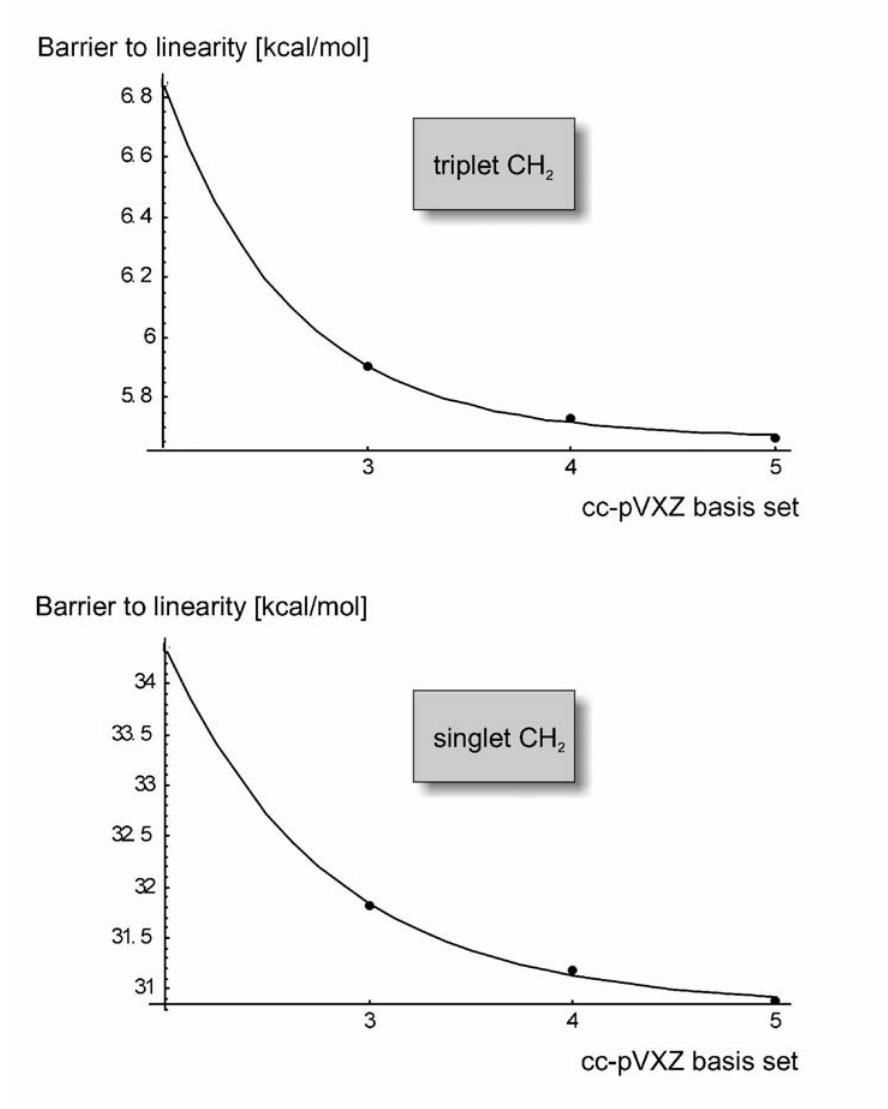
Figure 1. Exponential behaviour of barriers to linearity for the cc-pVXZ (X = 2 - 5) basis set expansion. Above: triplet CH